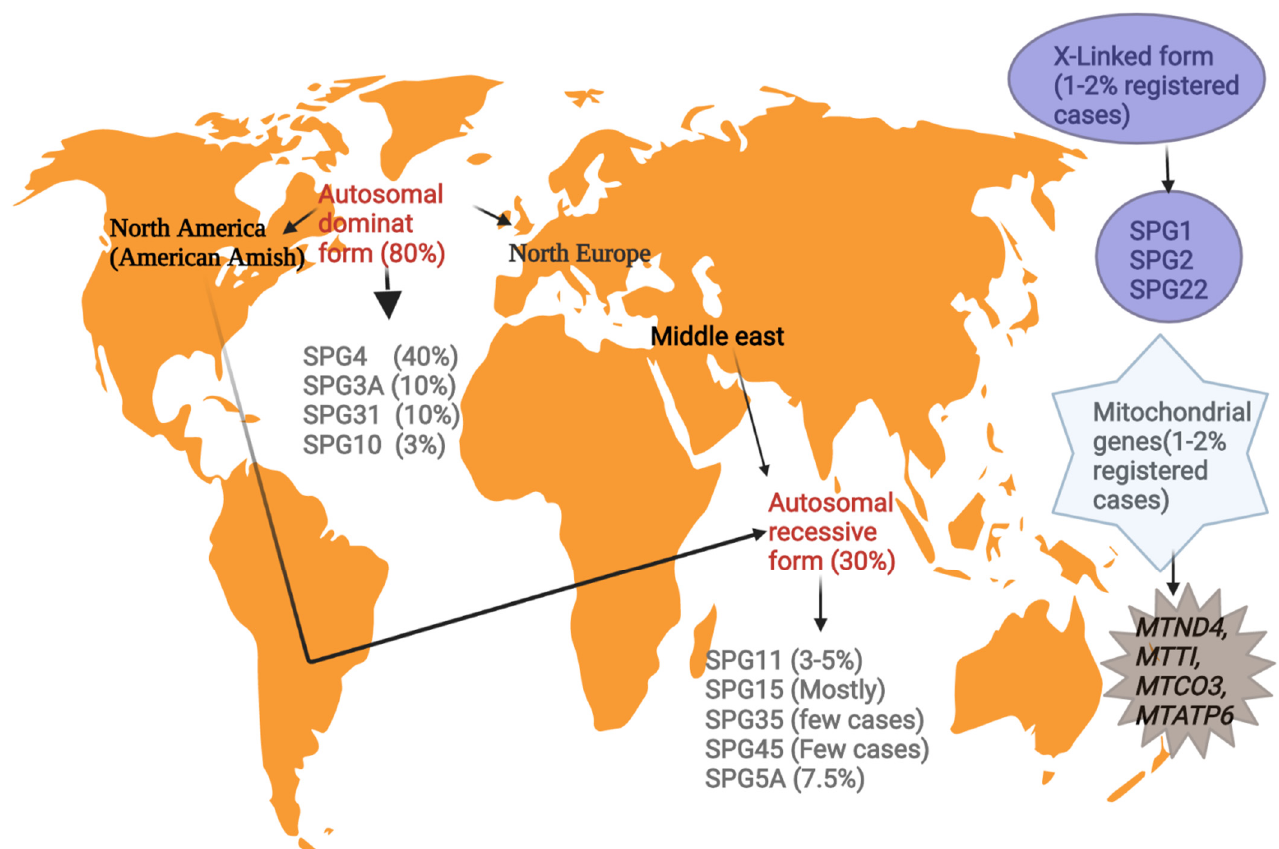
Figure 1. Illustrates the genetic epidemiology of the major HSP phenotypes around the